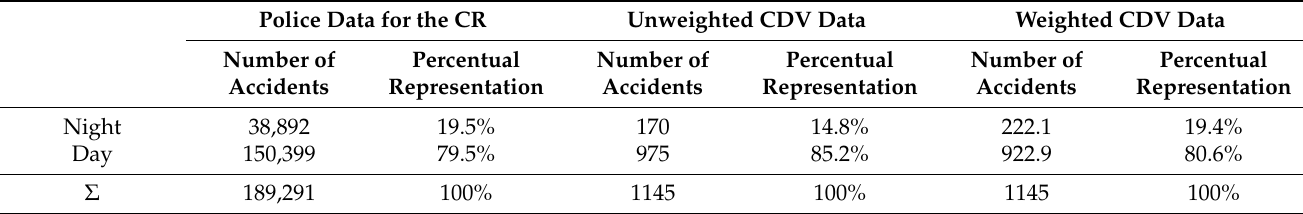
Table 3. Resulting weighted values for the accident daytime variable in the Czech